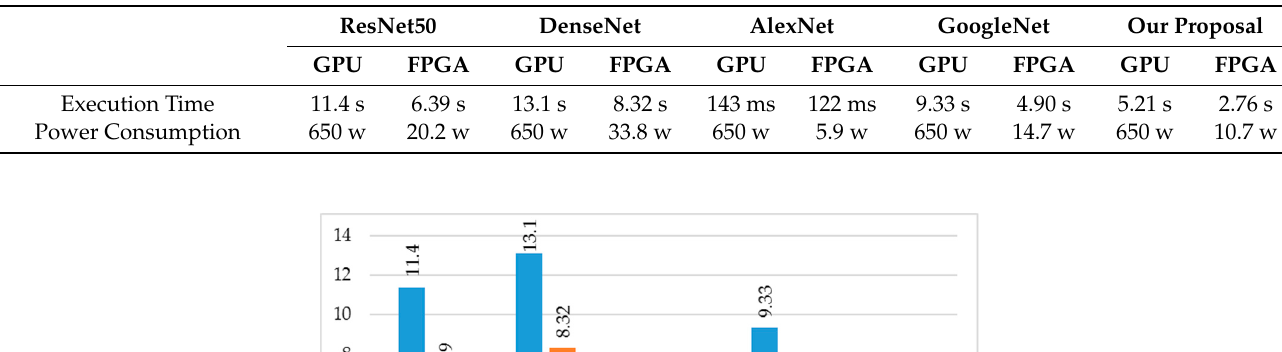
Table 3. Comparison between our proposed network and other pre-trained CNN models in terms of time execution and power consumption.